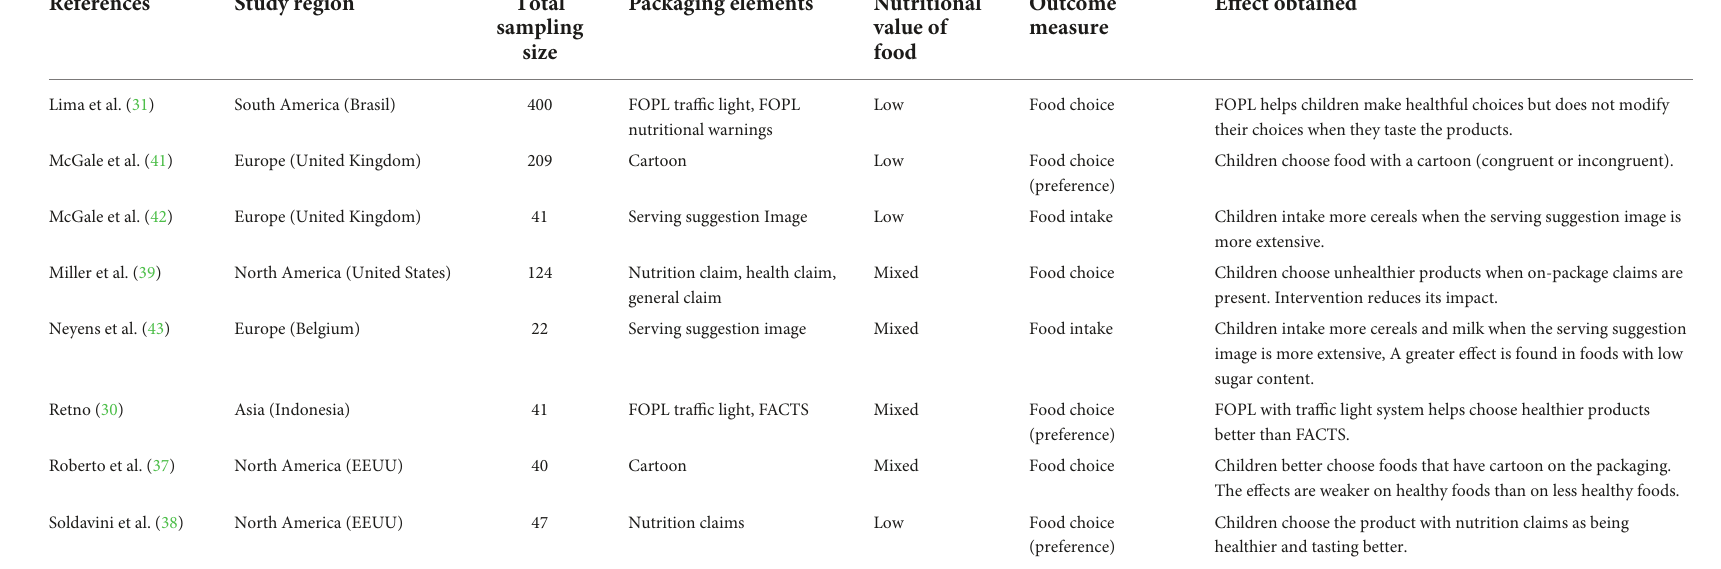
Children choose the product with nutrition claims as being healthier and tasting